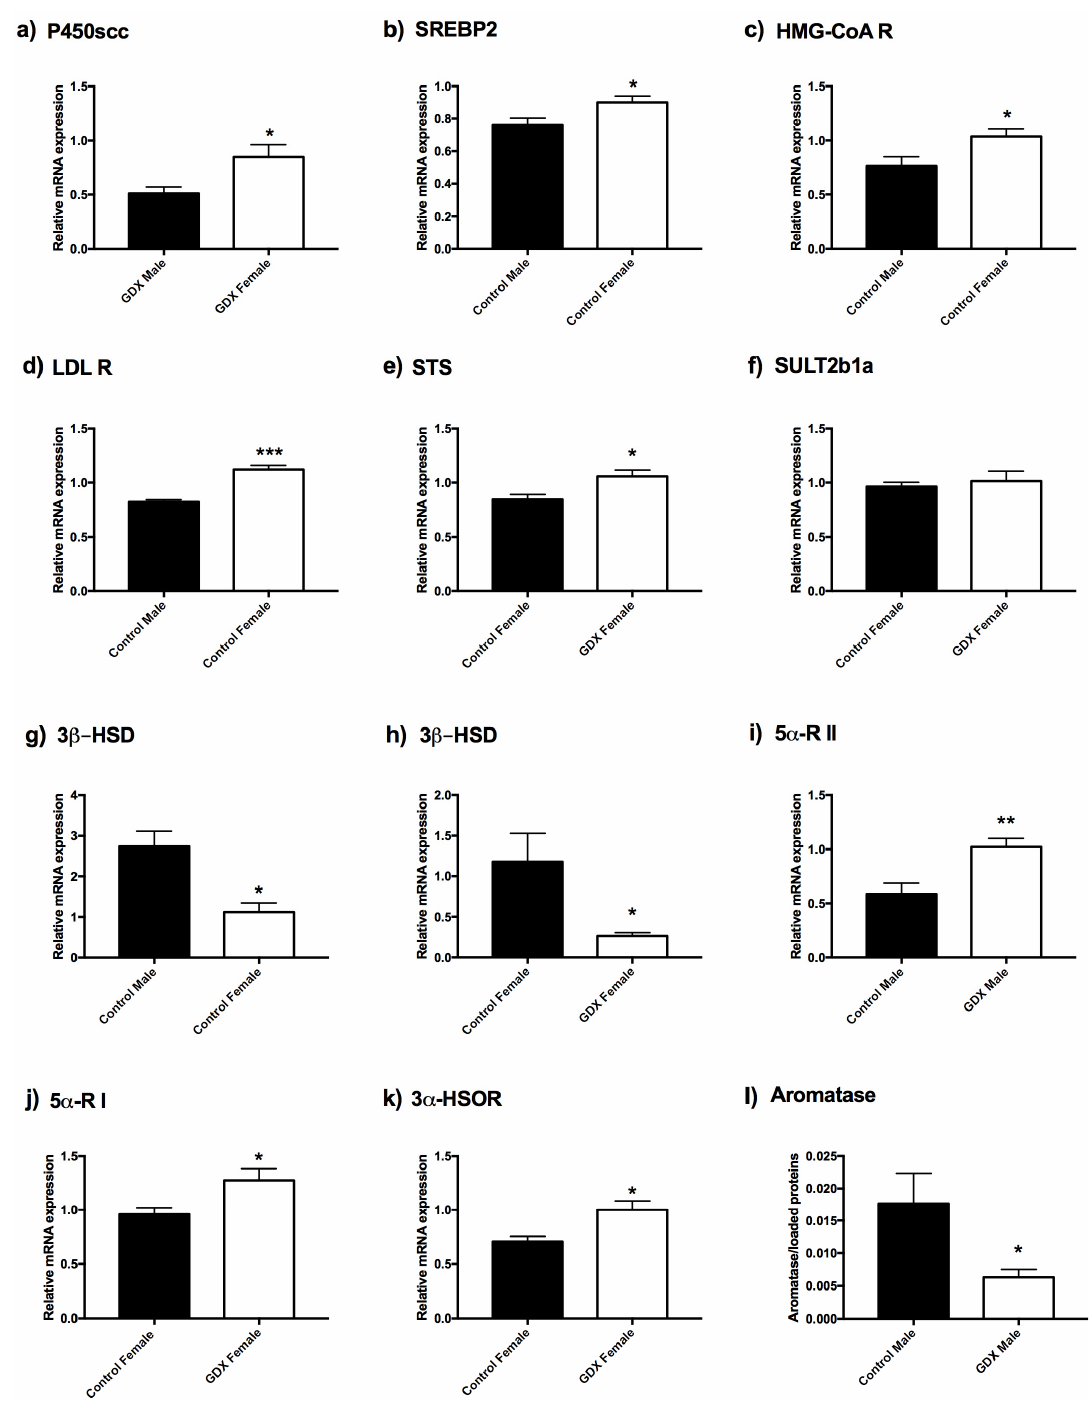
Figure 2. Expression of enzymes detected in rat colons. Data were obtained by real time PCR in panels ( a ) cholesterol side-chain cleavage enzyme (P450scc); ( b ) sterol regulatory element-binding protein 2 (SREBP2); ( c ) 3-hydroxy-3-methylglutaryl-coenzyme A reductase (HMG-CoA R); ( d ) low- density lipoprotein receptor (LDL R); ( e ) steroid sulfatase (STS); ( f ) hydroxysteroid sulfotransferase (SULT2B1); ( g , h ) 3 β -hydroxysteroid dehydrogenase (3 β -HSD); ( i ) 5 α -reductase type II (5 α -R II); ( j ) 5 α -reductase type I (5 α -R I); ( k ) 3 α -hydroxysteroid-oxidoreductase (3 α -HSOR), and by Western blot analysis in panel ( l ) aromatase. The columns represent the mean ± SEM after normalization with 36B4 rRNA in colon of adult rats. n = 6 animals for each experimental group. The unpaired Student’s t -test was used for statistical analysis. * p < 0.05, ** p < 0.01, *** p <